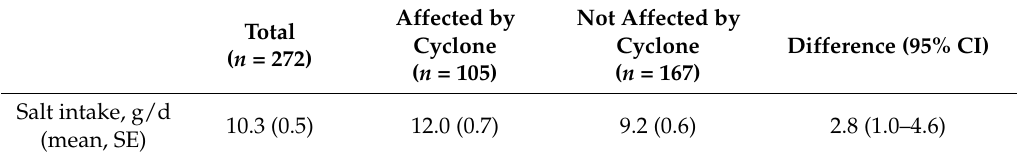
Table 5. Differences in salt intakes of people surveyed before and after the cyclone. Affected by Not Affected Total Cyclone ( n = 272) ( n = 105)